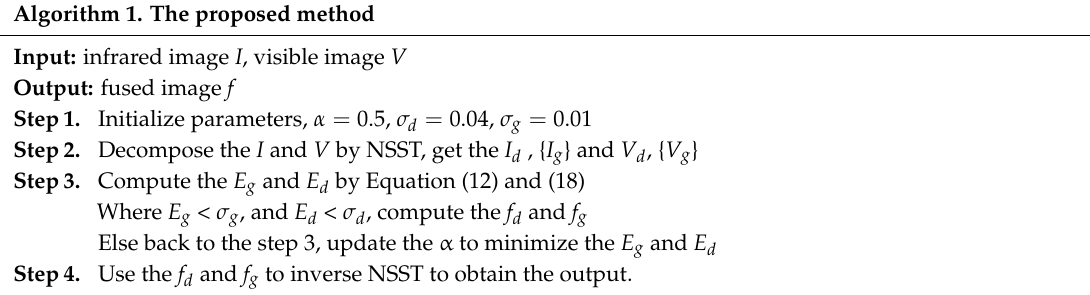
Algorithm 1. The proposed method